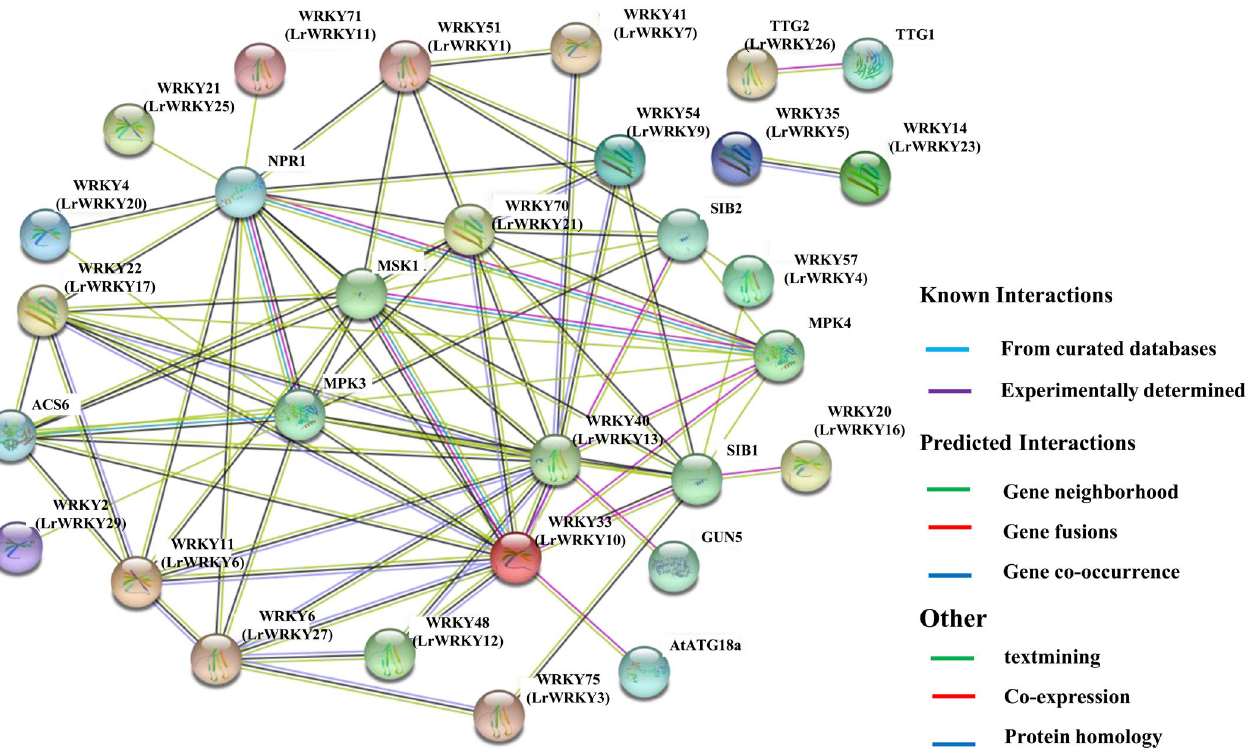
Figure 9. The predicted network of protein–protein interactions between LrWRKYs using the STRING database. Different colors represent different interaction types. Arabidopsis WRKY names are marked, whereas their homologs in L. radiata are in parentheses.